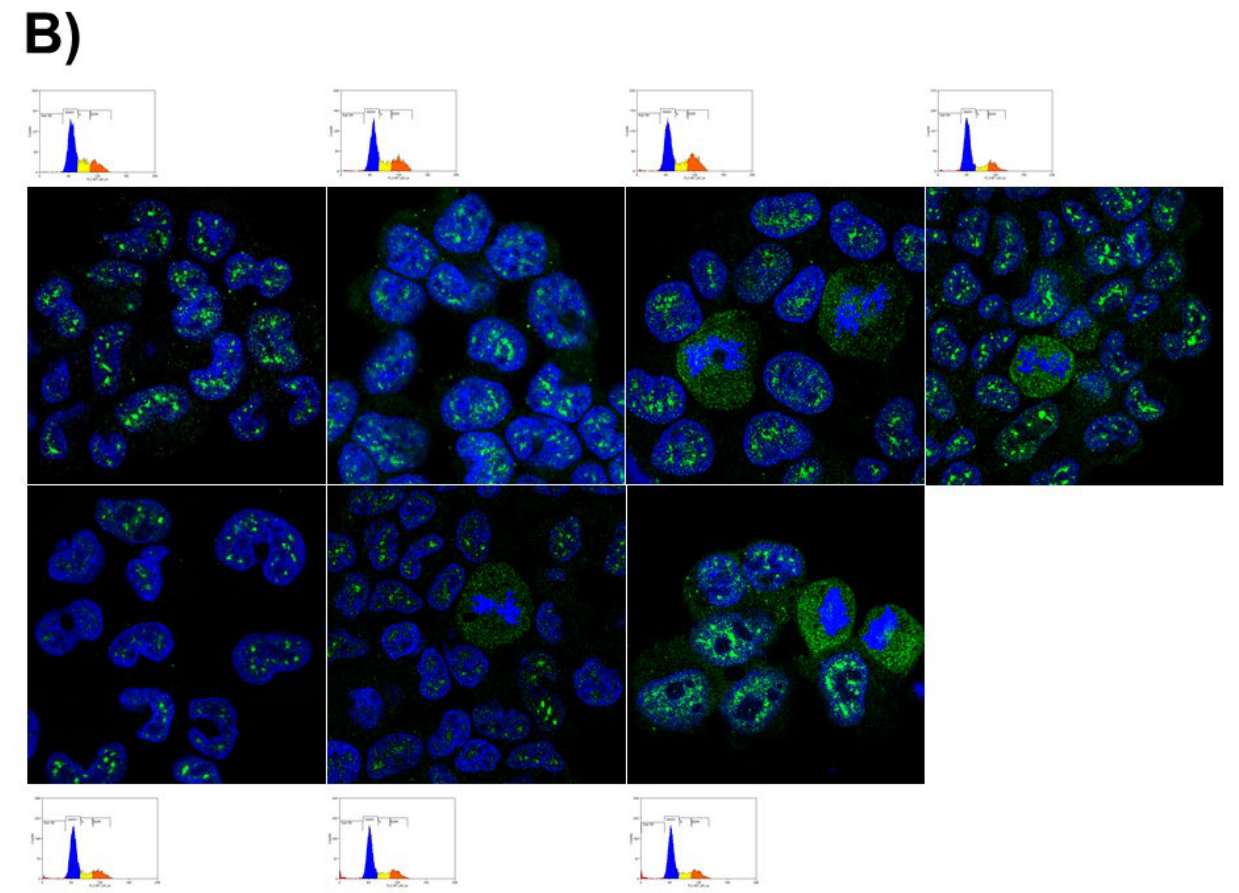
Figure 4. Intracellular distribution of PON1 in ( A ) HepG2 and ( B ) COV434 after cell cycle synchronization. Cells were synchronized and fixed or released for up to 48 h and then fixed. The PON proteins appear in green. Nuclei were stained with DAPI (blue). Confocal images were taken at the indicated times after the cell cycle resumed. Small inserted graphs represent cell distribution along the different cell cycle steps.